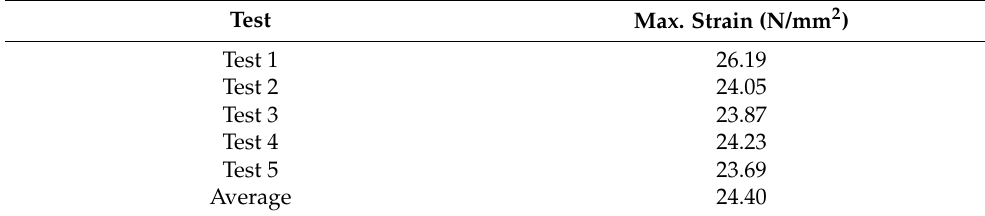
Table 8. Consolidated results of the tensile tests on specimens obtained in a duralumin mold.